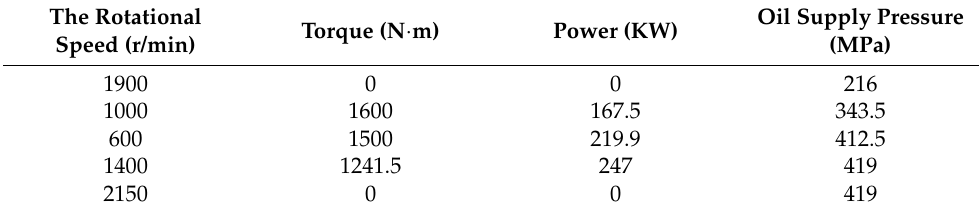
Figure 3. Measured cylinder pressure curve on each operating condition. Table 4. Measured parameters under each operating condition.